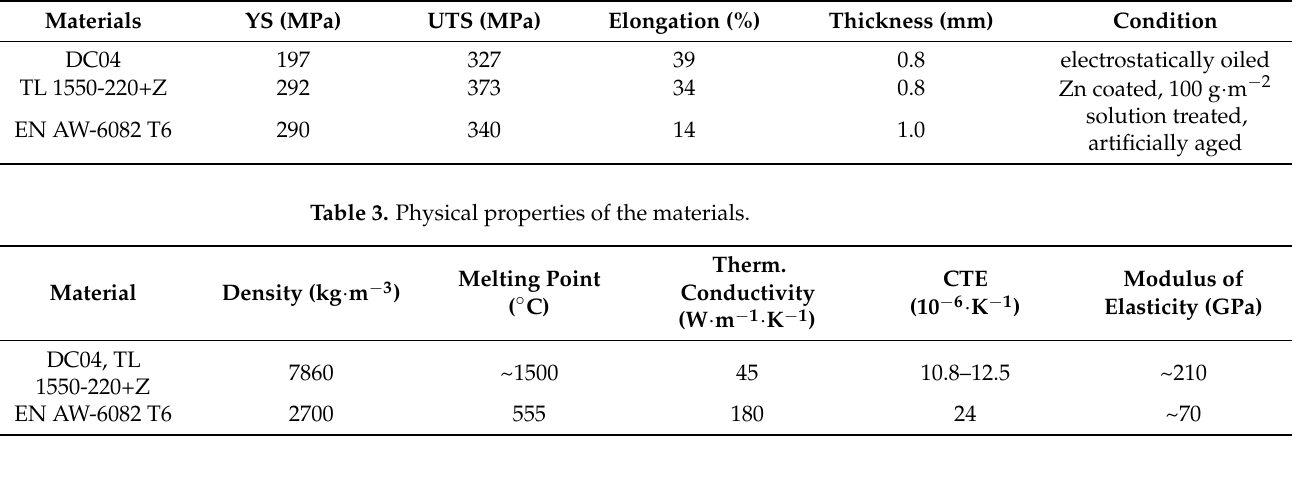
Table 2. Mechanical properties and some specific conditions of the materials.